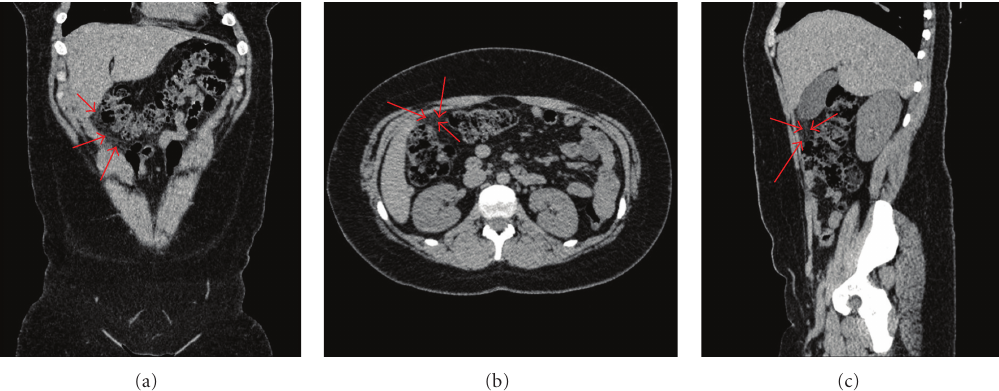
Figure 1: Unenhanced CT images (a) coronal, (b) axial, (c) sagittal show a focal area of hyperattenuating omental fat stranding (arrows).